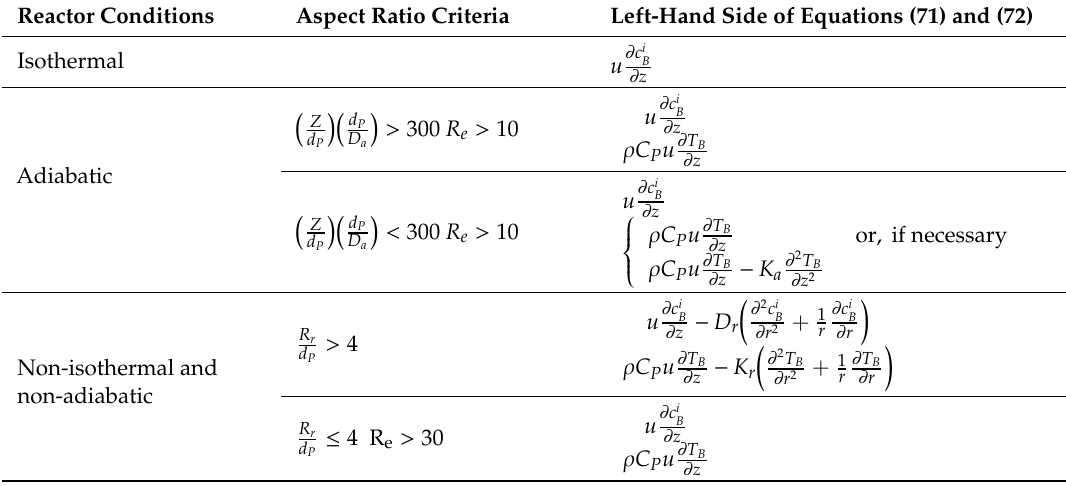
Table 3. Guidelines for simplifications in the left-hand side of conservation equations, with reference to stationary